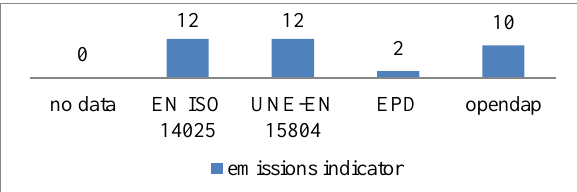
Figure 13. Metal category: steels.